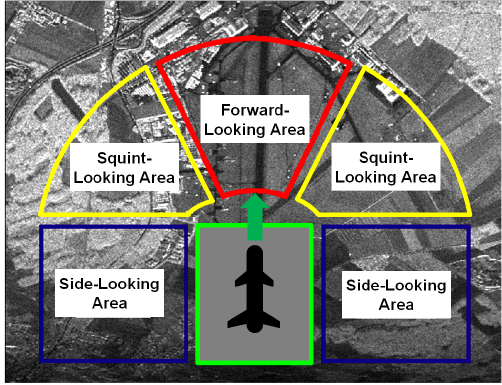
Figure 1. Different synthetic aperture radar (SAR)